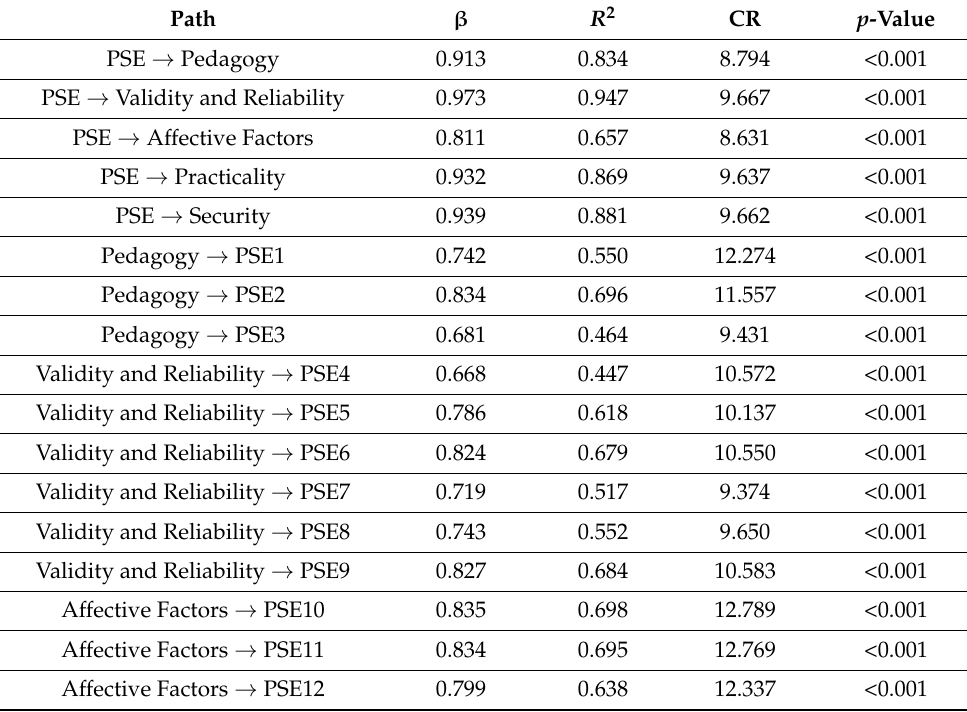
Table 4. Analysis Summary of Scalar